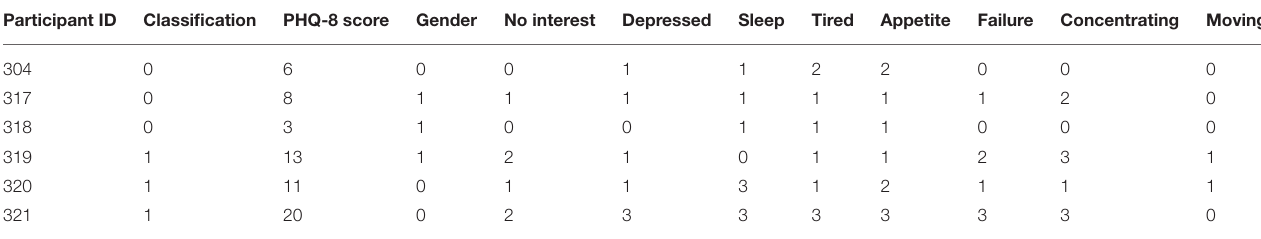
TABLE 1 | DAIC-WOZ sample examples.